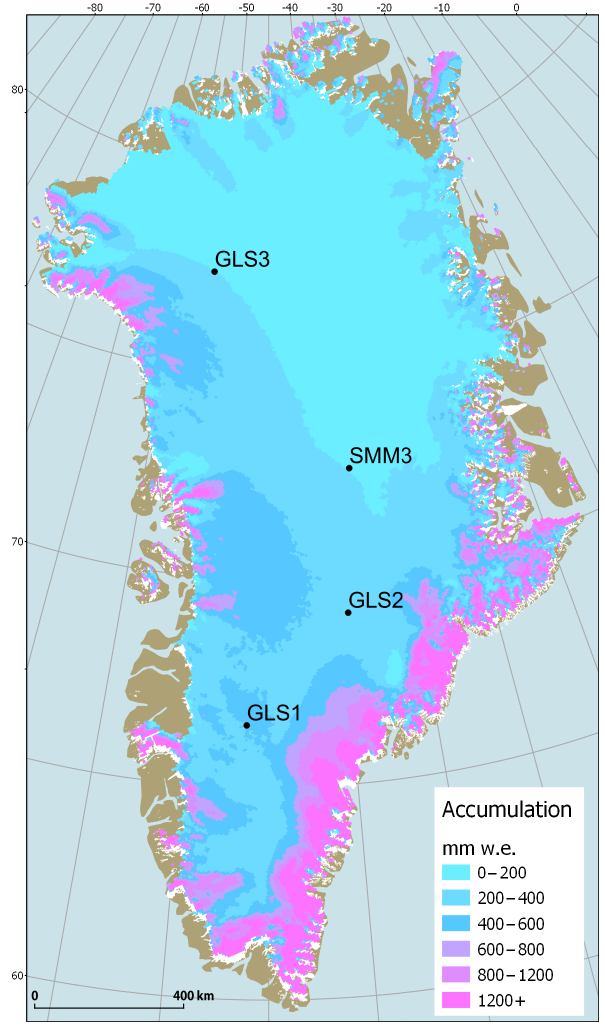
Figure 2. Map locations of the GLISN GPS sites and SMM3 (Sum- mit Camp). Mean annual snow accumulation rates (water equiva- lent) are also shown (Mottram et al.,